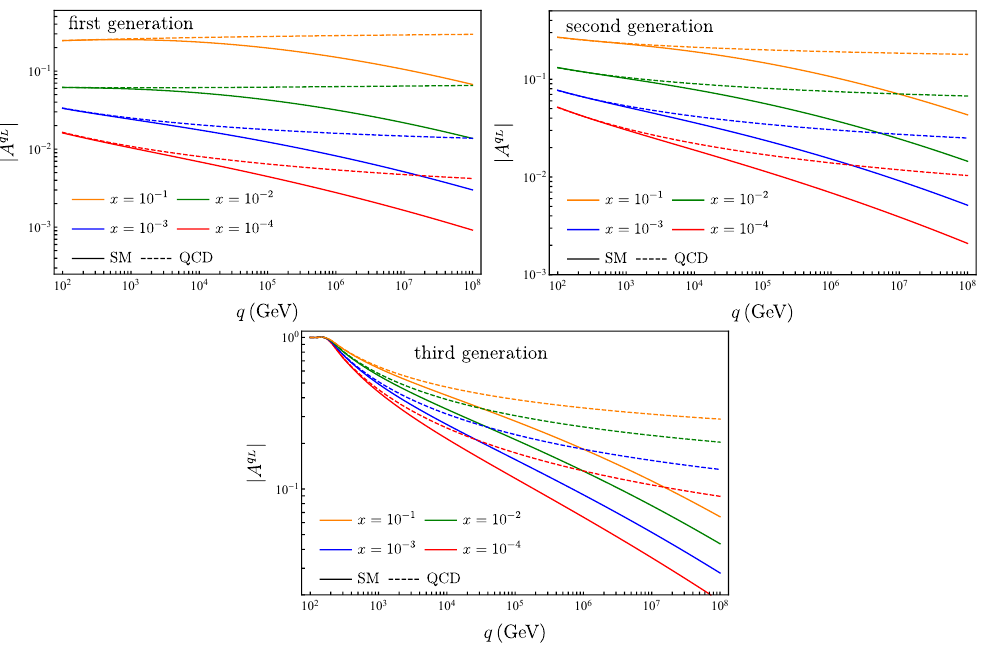
Figure 2 . Asymmetry between up-isospin and down-isospin left-handed quark PDFs, de(cid:12)ned in eq. (4.1), in the full unbroken SM, compared to the result when only QCD evolution is